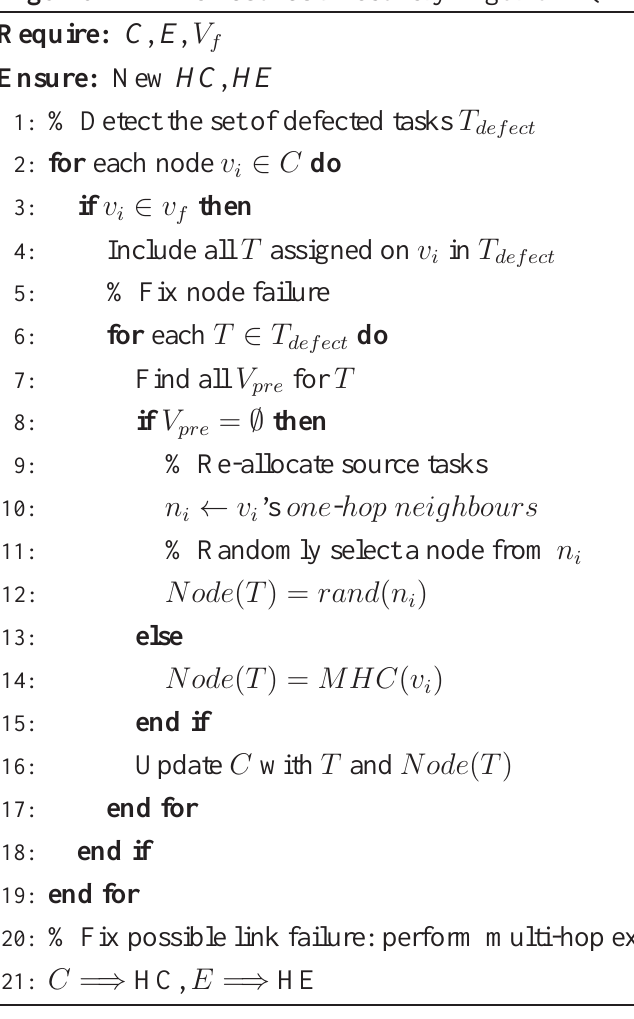
Algorithm 2 The Fast Task Recovery Algorithm (FTRA)